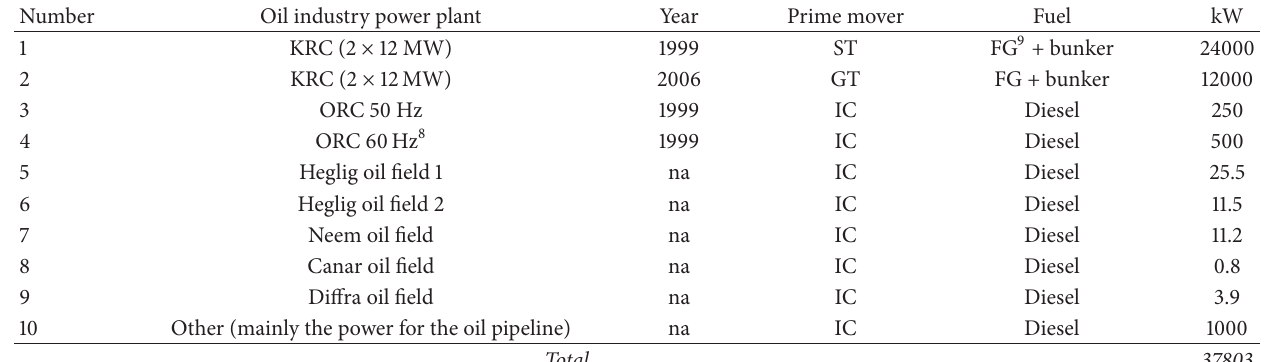
Table 5: Oil industry thermal power generation